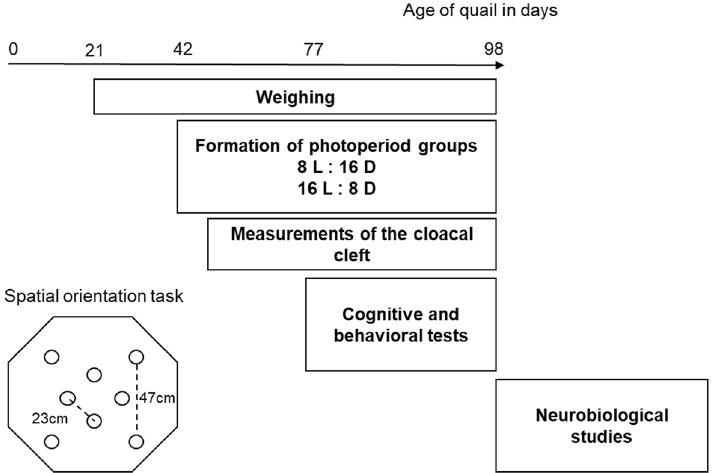
Figure 1. Schedule of the experiment and schematic representation of the apparatus used for the spatial orientation task. At 42-day old, quail were submitted to photoperiodic changes that lasted for the whole experiment. At 77-day old, short and long photoperiod birds (SP and LP, respectively) were trained in a spatial orientation task. At the end of the cognitive testing, animals were submitted to three different behavioral